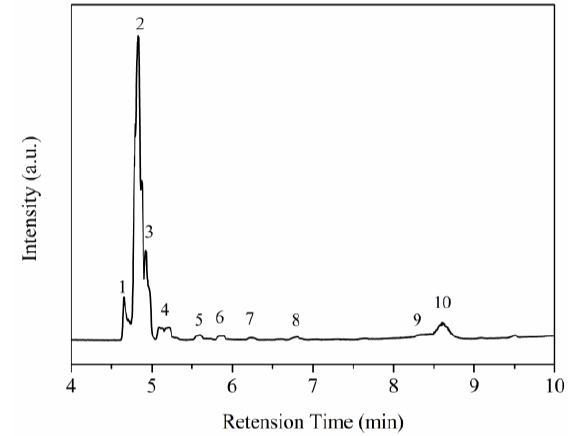
Figure 6. The total ion chromatogram (TIC) of volatile products evolved from TGA during thermal decomposition of P(ND- co -D) precursor at 310 °C.